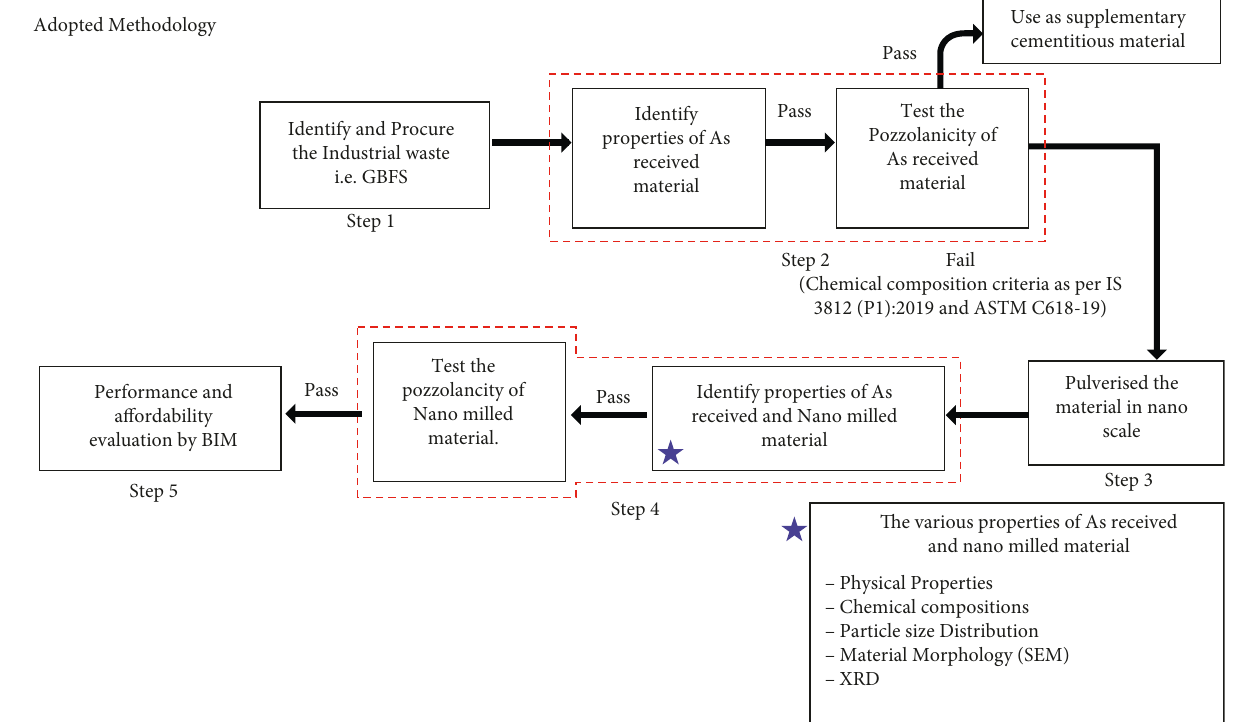
Figure 2: Flow diagram for the methodology adopted for the experimental work.